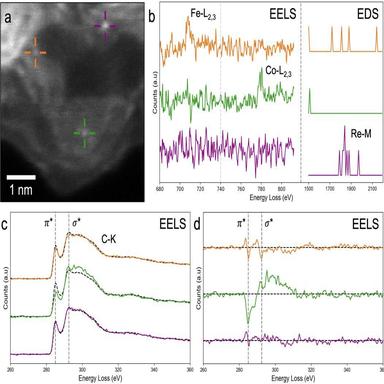
Automated metal atom position identification, probe positioning, and simultaneous EELS-EDS point spectra acquisition. (a) HAADF image showing a selection of atoms where spectra were acquired, as indicated by the crosshairs. (b) EELS and EDS results from individual atoms automatically identified and probed. Combining EELS and EDS allows a wide range of elements to be identified. Here, EELS can detect Fe and Co but not Re, while EDS can detect Re, allowing each type of metal atom to be identified spectroscopi